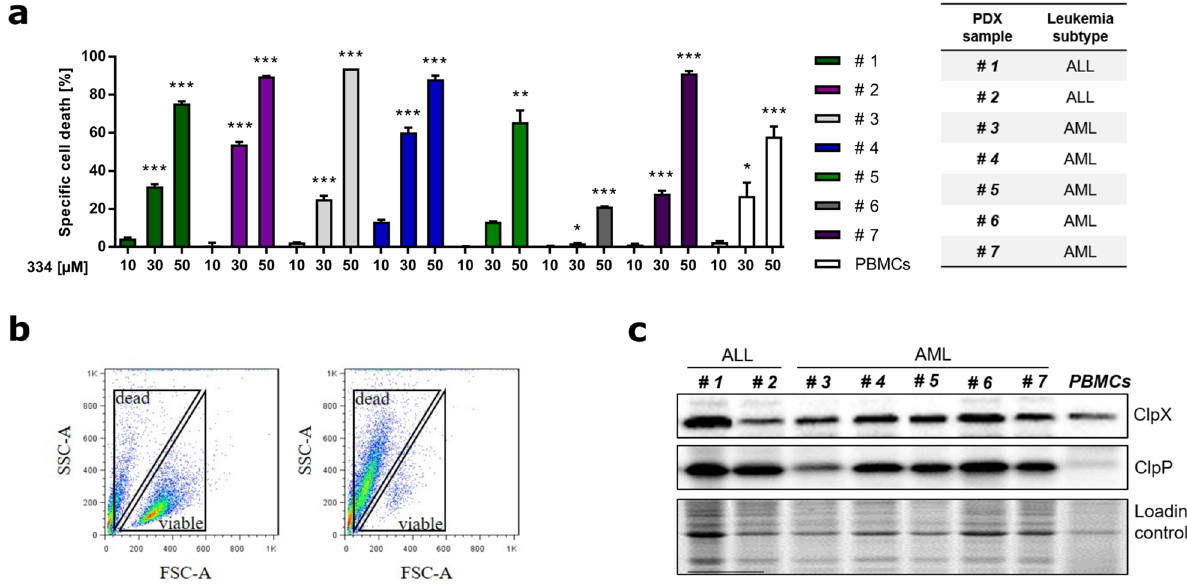
Figure 3. 334 induces cell death in ALL and AML PDX cells and PBMCs. ( a ) 334 induces cell death in all tested PDX leukemia cells. Specific cell death of PDX cells (n = 1) and isolated PBMCs (n = 3) treated with 334 for 48 h is shown (* P < 0.05, ** P < 0.01, *** P < 0.001, One-way ANOVA, Tukey’s Multiple Comparison Test, n = 1(PDX)/n = 3 (PMBCs), 5 repeated measurements). ( b ) The specific cell death was quantified by flow cytometry as shown by a representative FSC-SSC scatter plot of untreated (left panel) vs. 334 treated (50 µM) PDX cells (right panel). ( c ) ClpX and ClpP protein expression does not correlate with 334 treatment efficiency. Western blot analysis for ClpX and ClpP protein expression in all tested PDX cells and PBMCs is shown (n = 1). Stain-free technology is used as a whole protein loading control. Full length blots are presented in Supplementary Fig. S8